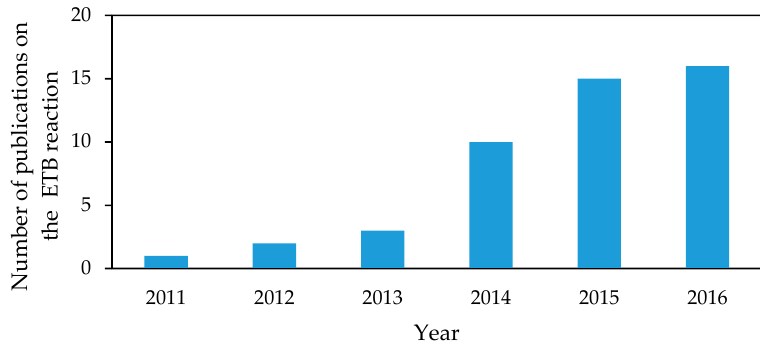
Figure 1. Number of publications dedicated to the ethanol ‐ to ‐ butadiene reaction in the recent years. ETB, ethanol ‐ to ‐ butadiene.